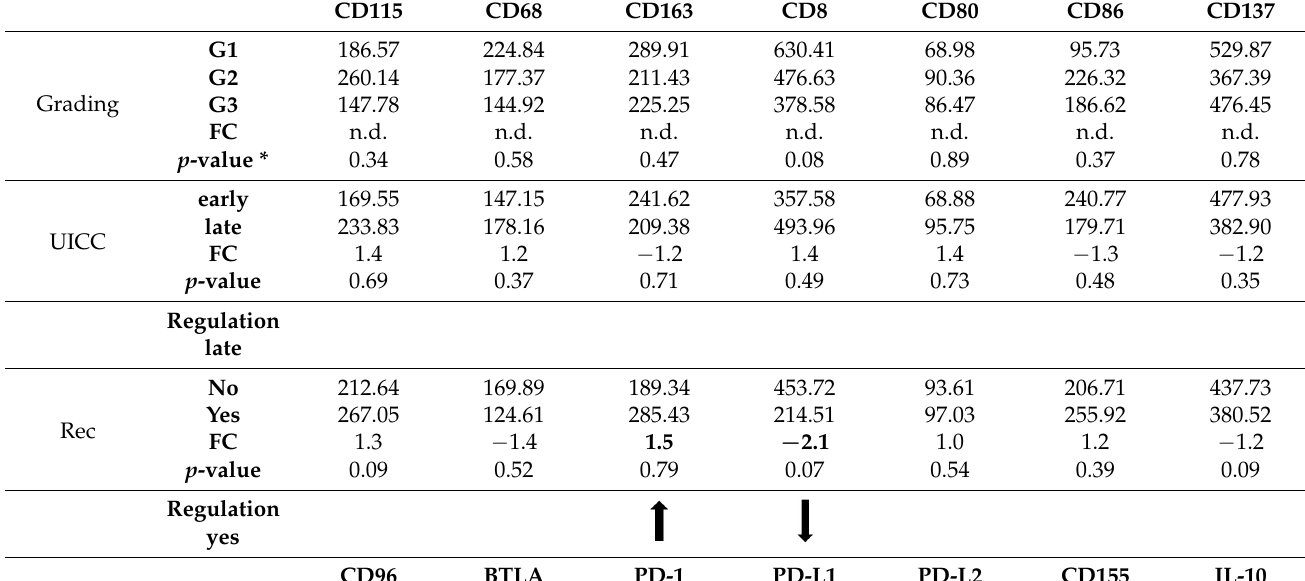
Table 4. Average of counts in specific groups, changes in expression levels (FC) and statistical rele- vance of differential expression in OSCC tissues depending on tumor size, lymph node status (N), clinical stage (UICC), grading (G) and recurrence (Rec.). Number of OSCC = 98. Statistically relevant 583.78 changes are highlighted in bold. All significances are calculated by means of the MWU test with the exception of grading (* Kruskal–Wallis Test). FC significance level was 1.5 times. Statistically rele- vant changes are highlighted in